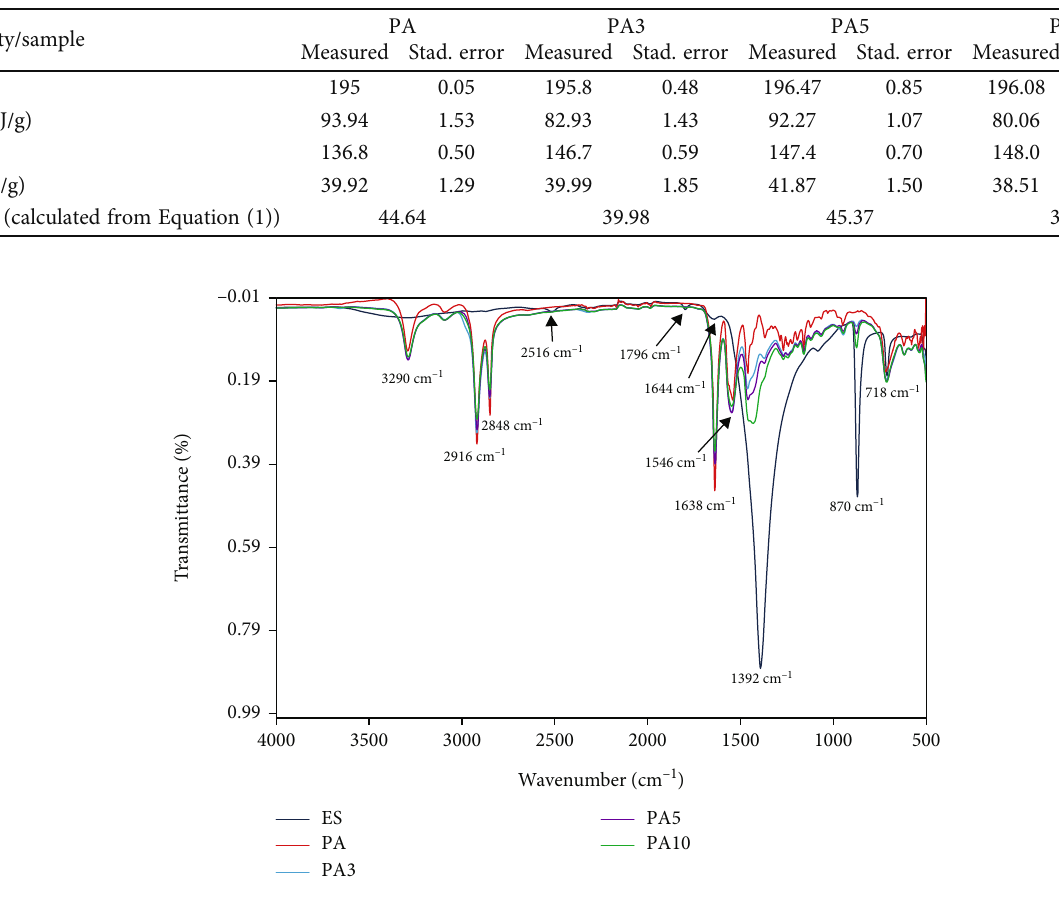
Figure 6: Fourier transform infrared (FTIR) spectra of PA and ES as well as ESPs/PA12 composites (PA3, PA5, and